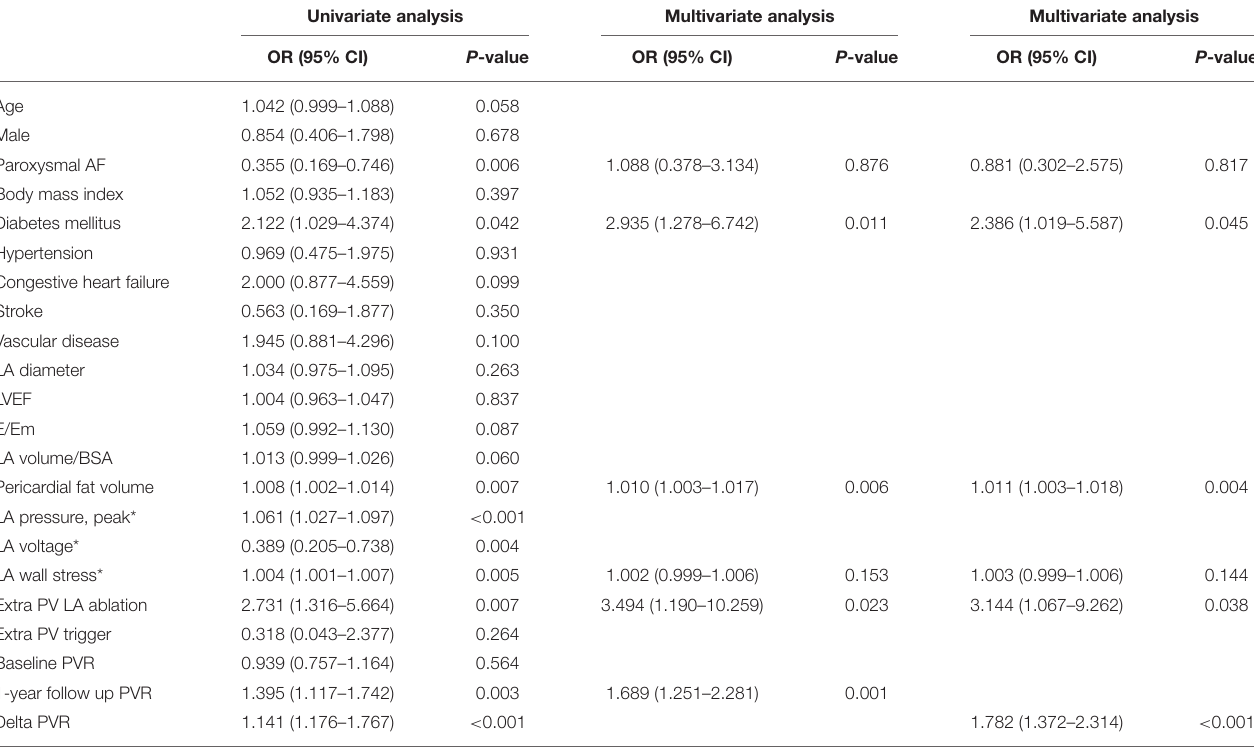
TABLE 3 | Logistic regression analysis of the stiff LA physiology in the patients. Univariate analysis Multivariate analysis Multivariate